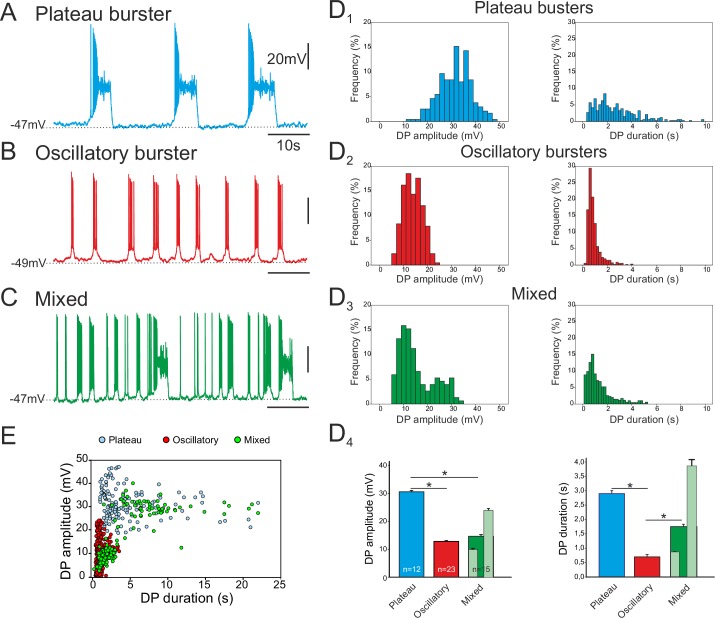
Different discharge patterns expressed by embryonic inspiratory pacemaker neurons.Patch-clamp recordings of individual pacemaker neurons from three different preparations expressing spontaneous plateau (A), oscillatory (B) or mixed plateau/oscillatory (C) burst firing patterns. (D) Histograms showing frequency distributions of the burst-generating dirve potential (DP) amplitude (D1–3, left column) and duration (D1–3, right column) for the three types of pacemaker neurons. D4: Histograms representing mean DP amplitude ± SEM (left) and mean DP duration ± SEM (right) for pacemaker neurons expressing plateau-like (blue bars), burst-like (red bars) or mixed (green bars; light green bars correspond to short-lasting and long-lasting bursts when grouped separately) activity. Asterisks indicate significant differences (Mann-Whitney test; p<0.001), while numbers of neurons analyzed for each pacemaker phenotype are indicated in the corresponding bar. (E) Distribution plot for DP duration vs DP amplitude measured for neurons recorded for 8 to 10 min (blue, plateau bursting pacemakers (n = 8); red, oscillatory bursting pacemakers (n = 5); green, mixed pacemakers (n = 5). Note that the latter expressed two types of burst duration/amplitude relationship that overlapped with either the purely plateau or oscillatory bursters.